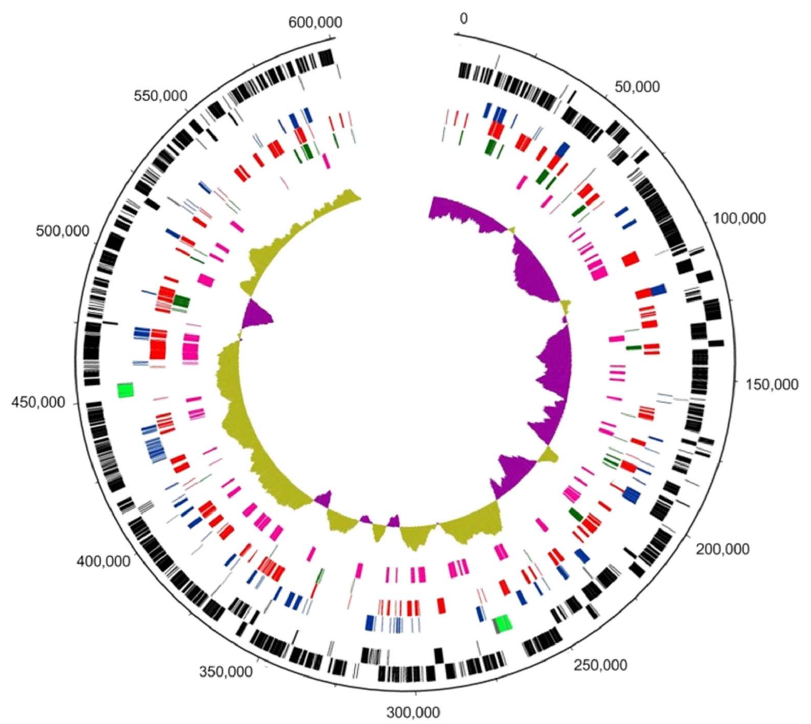
Figure 1. Genome circle of ‘ Ca . P. mali’ strain AT highlights gene expression. Circular patterns (from outside to inside): 1 (outer circle), scale in base pairs of the chromosome; 2 (black), predicted protein coding sequences; 3, tRNAs (grey) & rRNAs (green); 4 (dark blue), identified proteins of ‘ Ca . P. mali’; 5 (red), expressed genes of ‘ Ca . P. mali’ identified by RNA-Seq; 6 (dark green), expressed genes (proteome and transcriptome) without similarity to NRPROT entries excluding the Acholeplasmataceae entries; 7 (magenta), assigned proteins of the mulberry dwarf phytoplasma; and 8 (olive and pink), G + C skew. Expressed genes located in the terminal ends (identical in sequence) were marked twice.